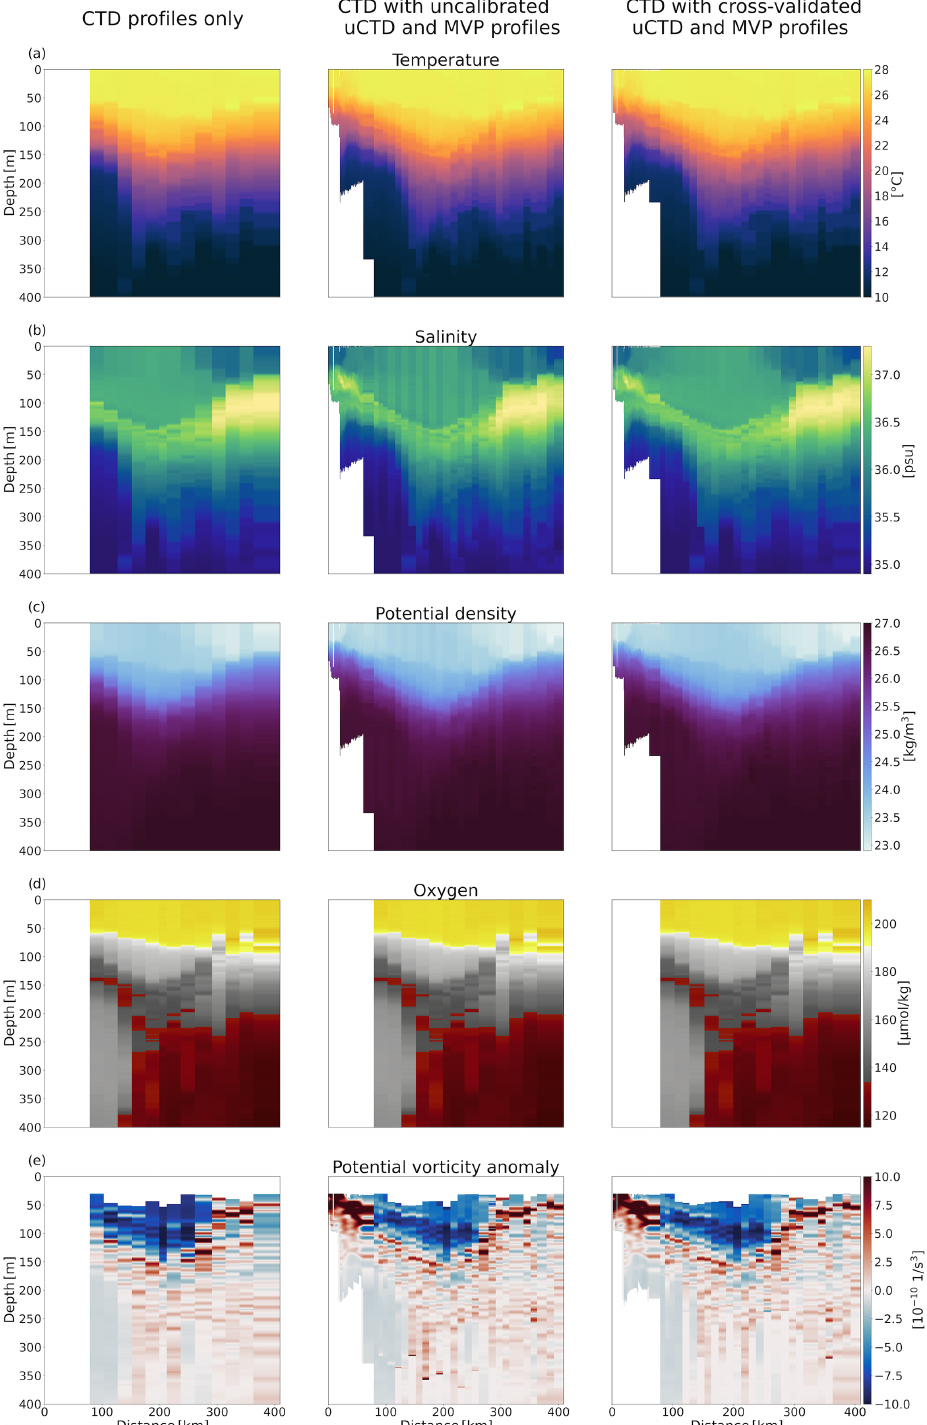
Figure 22. Vertical sections of thermohaline and dynamic characteristics performed by R/V L’Atalante . The first column shows the section with only the CTD profiles. In the second column the uncalibrated profiles of MVP and uCTD are added. The third column is the same but for calibrated profiles. Panel (a) is for temperature, panel (b) for salinity, panel (c) for potential density, panel (d) for oxygen (only CTD profiles measured oxygen), and panel (e) for Ertel’s potential vorticity based on the ADCP measurements (not